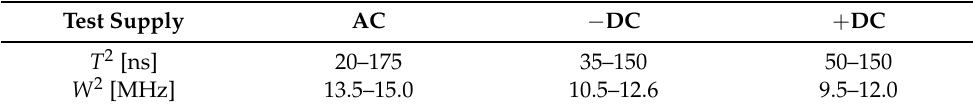
Table 3. Comparison of mobile pulse characteristics at the three types of voltage stress.